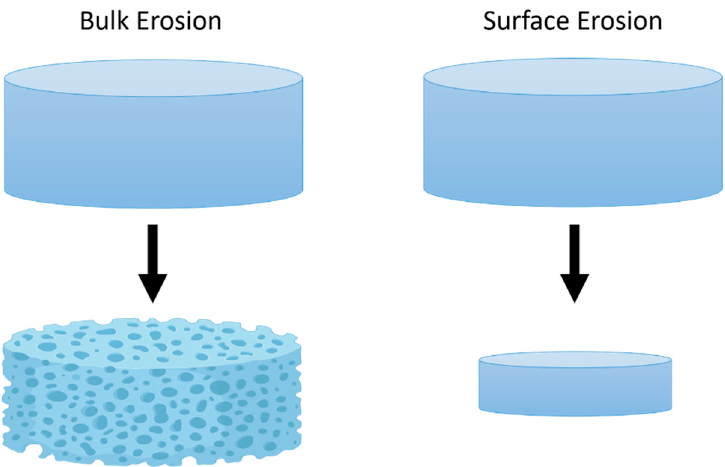
Figure 2. Simplified illustration of bulk erosion and surface erosion of compressed